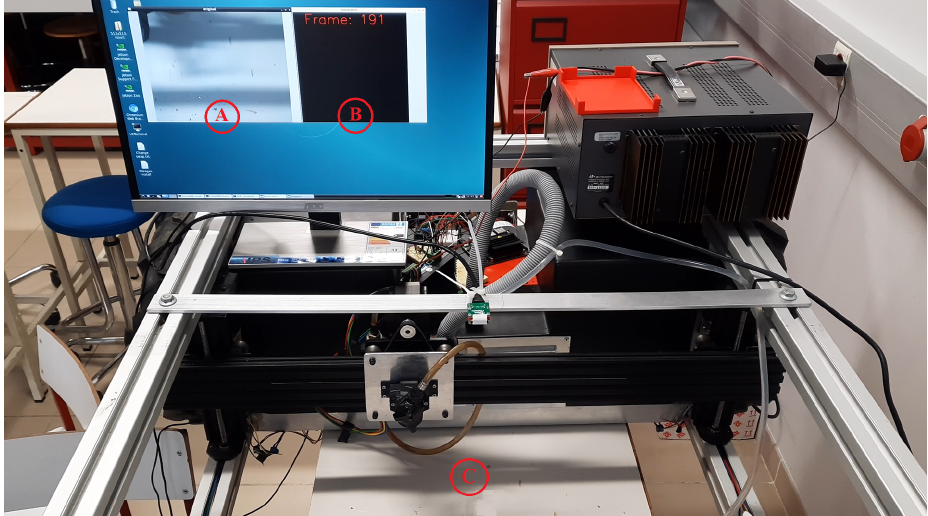
Figure 12. General view of the experimental results. ( A ) is the window in which the input image coming from the camera is displayed. ( B ) is the window in which the segmented image is displayed. ( C ) is the area where the weed was placed.